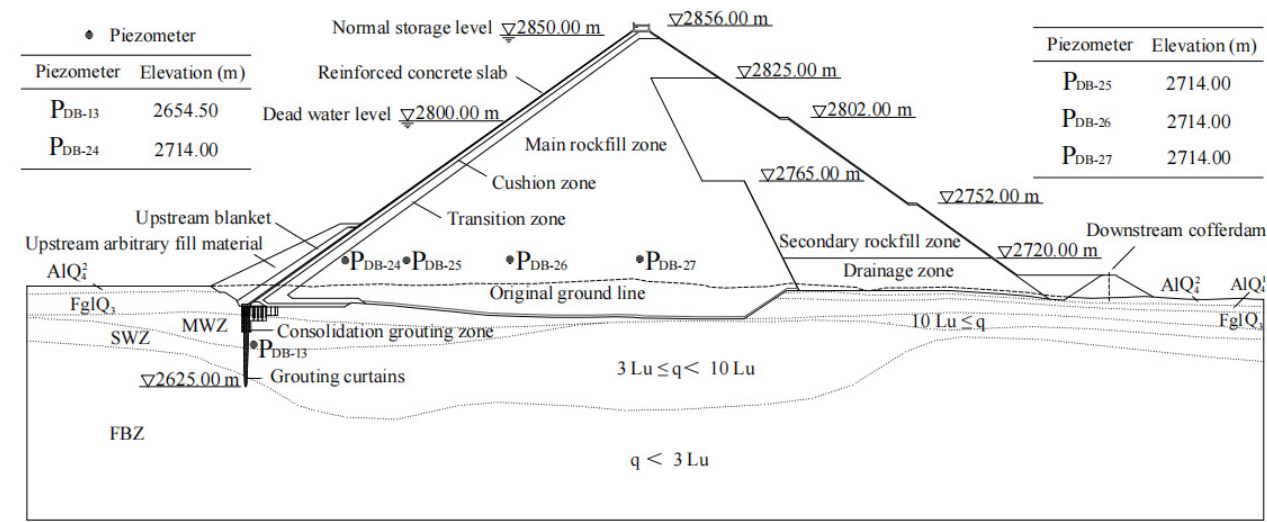
Figure 5. The max cross-section of the dam body.